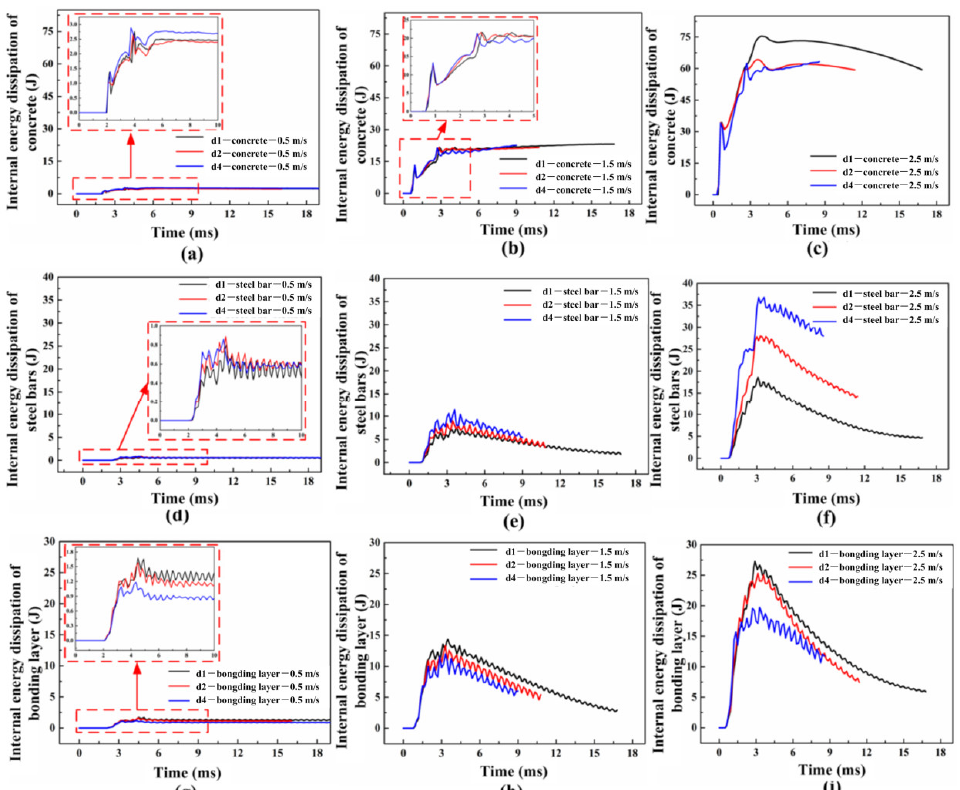
Figure 19. The internal energy dissipation for each of the components under three impact velocities.